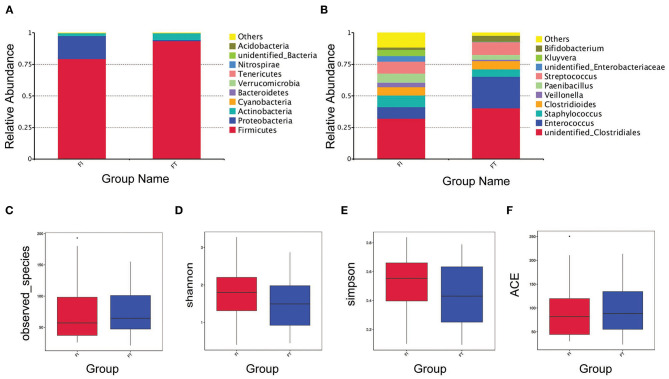
Overview of the preterm infant gut microbiome and the α-Diversity. Relative abundance of bacteria at phylum level (A) and at genus level (B) between FT and FI groups. α-diversity analysis in the sample groups including observed-species (C), Shannon index (D), Simpson index (E) and ACE index (F).